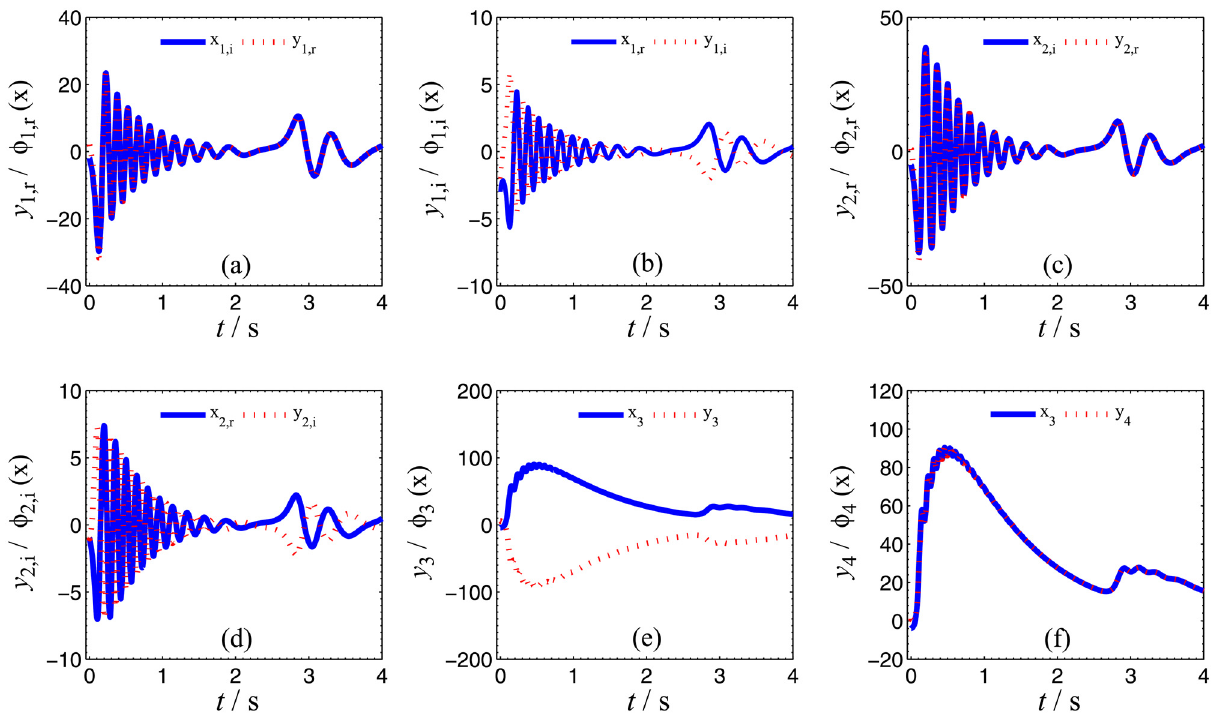
Fig 7. CGS process of systems (19) and (13) with respect to the given complex map vector ϕ ( x ) = [ − j x 1 , − j x 2 , − x 3 , x 3 ] T . (a) x 1,i , y 1,r ; (b) x 1r , y 1,i ; (c) x 2,i , y 2, x y x y x y r ; (d) 2,r , 2,i ; (e) 3 , 3 ; (f) 3 , 4 .